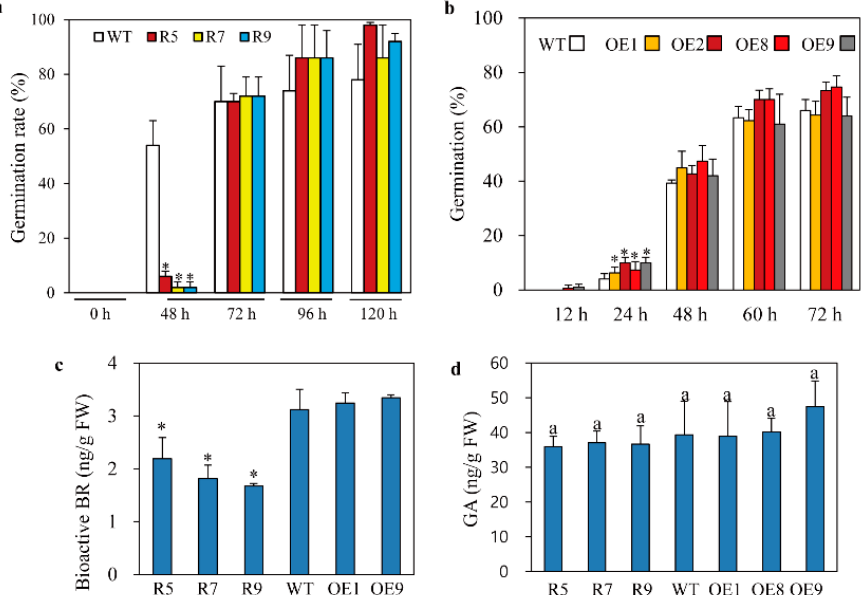
Figure 4. Germination rates and bioactive BR and GA levels. ( a ) Time course of snat2 rice germination. ( b ) Time course of SNAT2 OE rice germination. ( c ) Bioactive BR levels. ( d ) Bioactive GA levels. Rice seeds were germinated under 14-h light / 10-h dark long day conditions for the germination test. BR and GA levels were quantified by ELISA using 7-day-old rice seedlings grown in half-strength MS medium. Different letters and asterisks indicate significant differences as determined by a post-hoc Tukey’s HSD test at p < 0.05. Data represent the mean ± standard deviation of triplicate experiments.